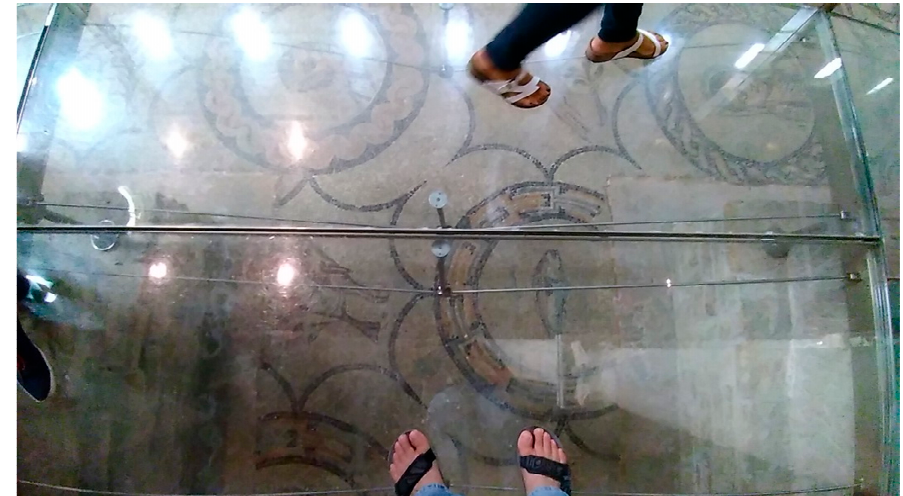
Figure 3. The role of transparency on magnified human perception of vibrations and discomfort feelings for the glass walkway object of investigation (photo by C. Bedon, courtesy of